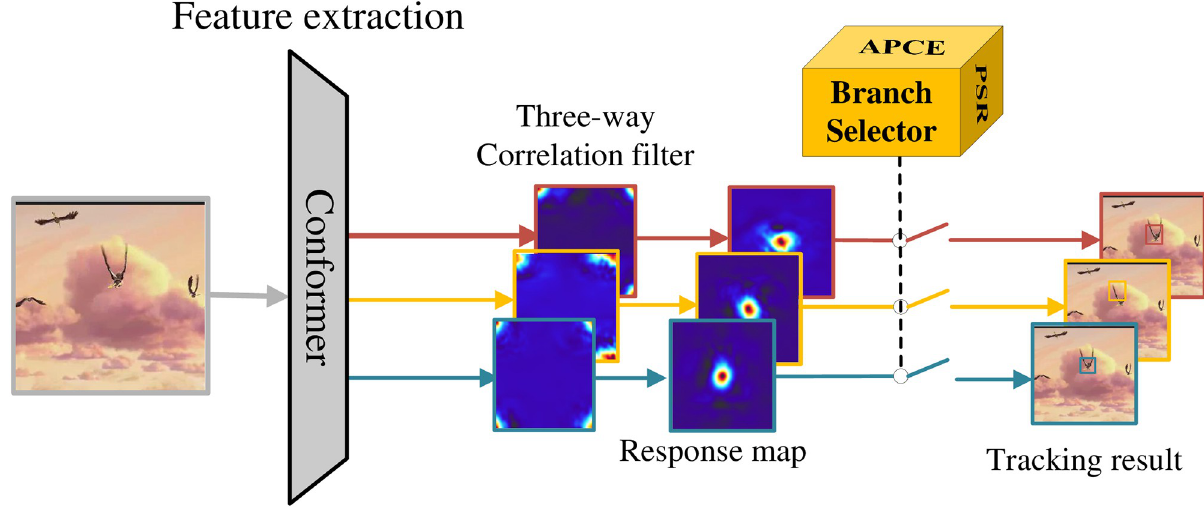
Fig 2. Three-way parallel correlation filter